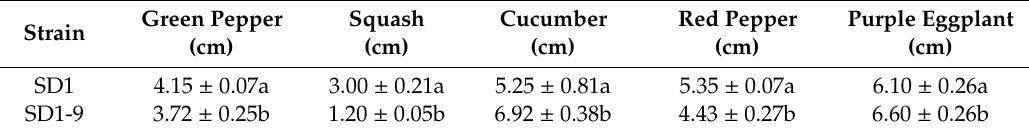
Table 1. Pathogenicity of the metalaxyl-sensitive and -resistant mutant strains of P. capsici on di ff erent vegetables.